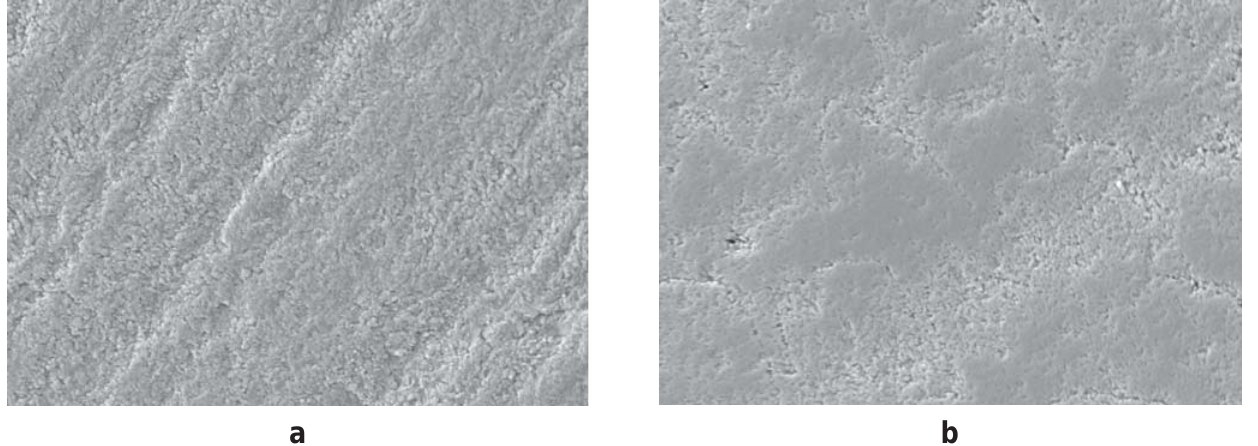
FIGURE 4- SEMs of ground (4a) and intact (4b) enamel surfaces treated with Brush & Bond self-etching adhesive. Adhesive treatment resulted in a mild etching pattern